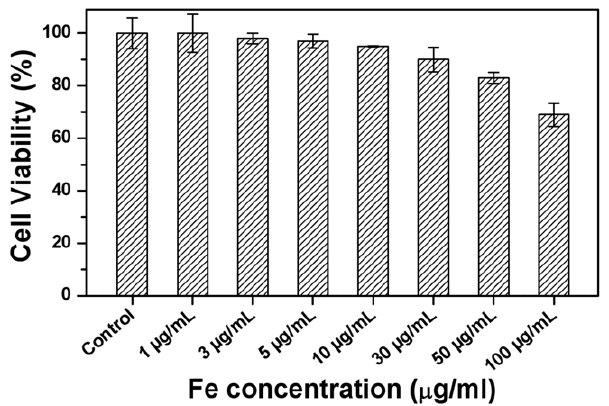
Figure 4. Optical microscopy images of PC3 human prostate cancer cells (control) grown for 24 h (A) in the absence of nanoparticles, and in the presence of (B) Mag and (C) Mag@SiO2 nanoparticles followed by three washings with PBS.